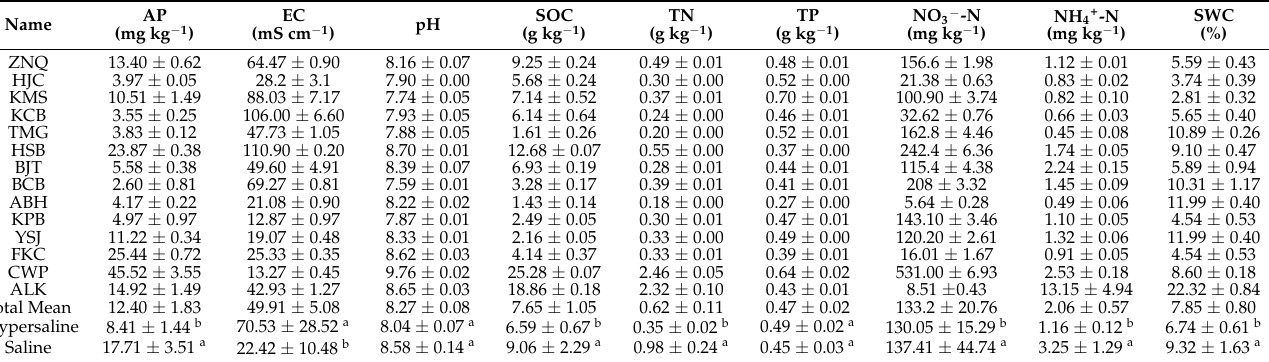
Table 1. Soil physicochemical properties in each geographic site, saline and hypersaline